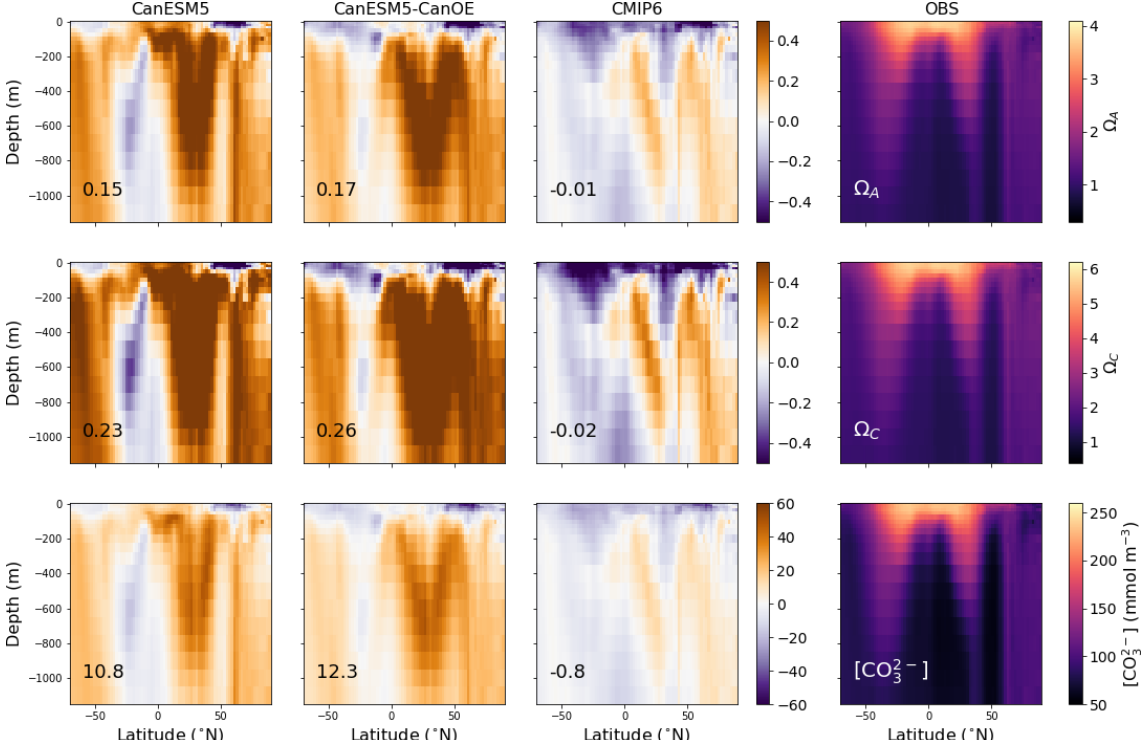
Figure 7. Latitude–depth distribution of zonal mean (surface to 1150m) aragonite saturation state ( (cid:127) A ), calcite saturation state ( (cid:127) C ), and carbonate ion concentration ([CO −− ]) in mmolm − 3 for CanESM5-CanOE, CanESM5, the mean for other CMIP6 models, and observations 3 (GLODAPv2 and WOA2018). Numbers on the lower left are the mean model bias. Differences from the observation-based fields are shown in Fig. S2 in the